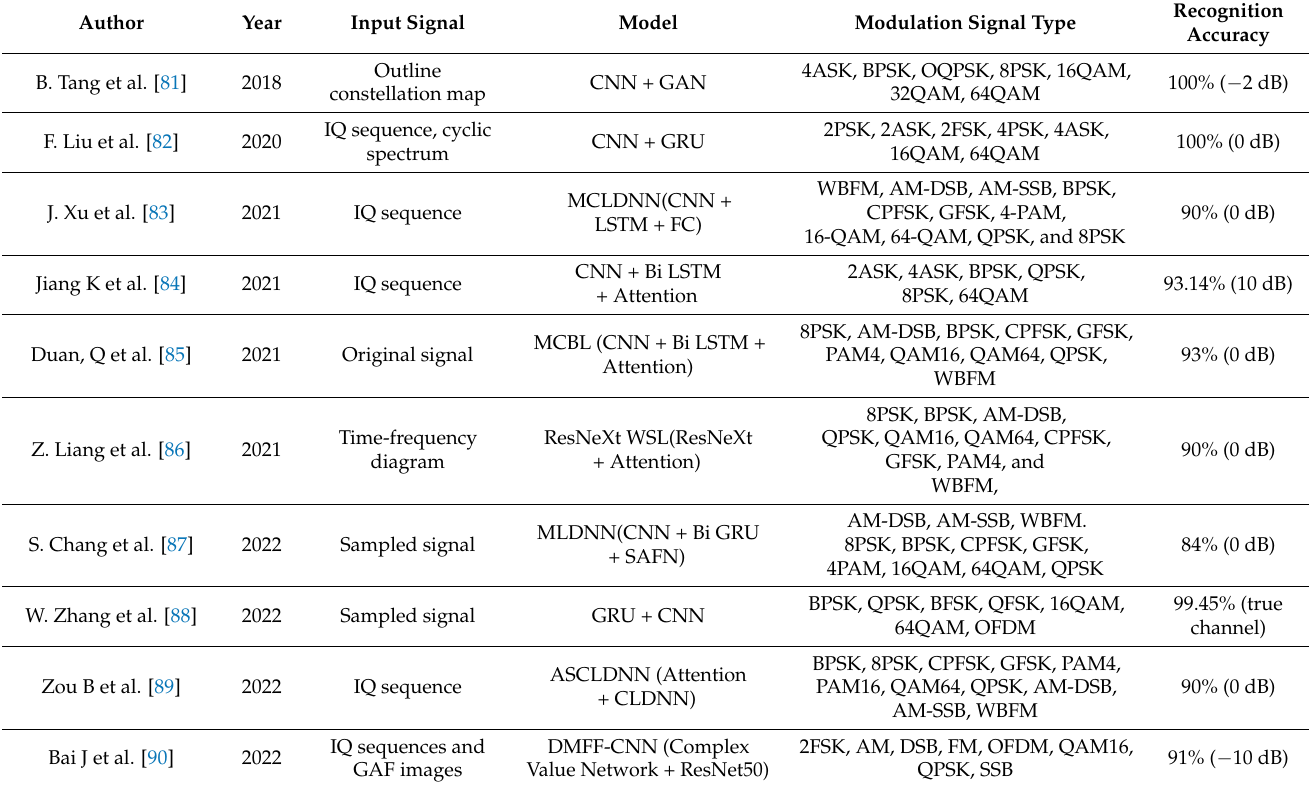
Table 3. Summary of modulation recognition algorithms based on combinatorial neural